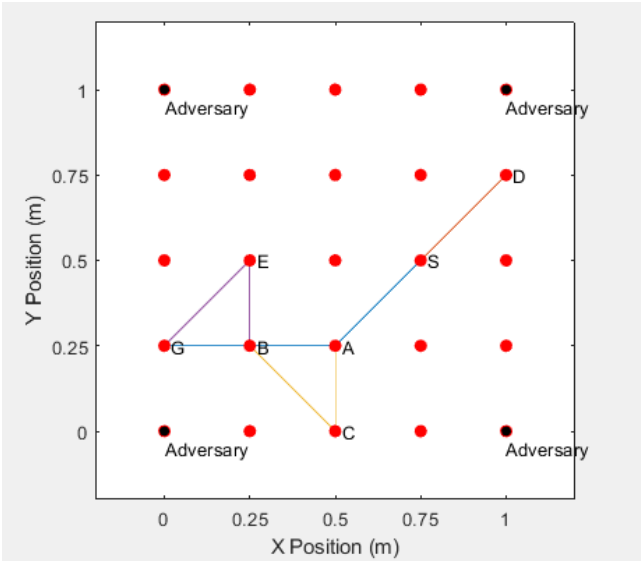
Figure 7. Location of Sensors and Adversaries and a Randomly Generated Network Topology.